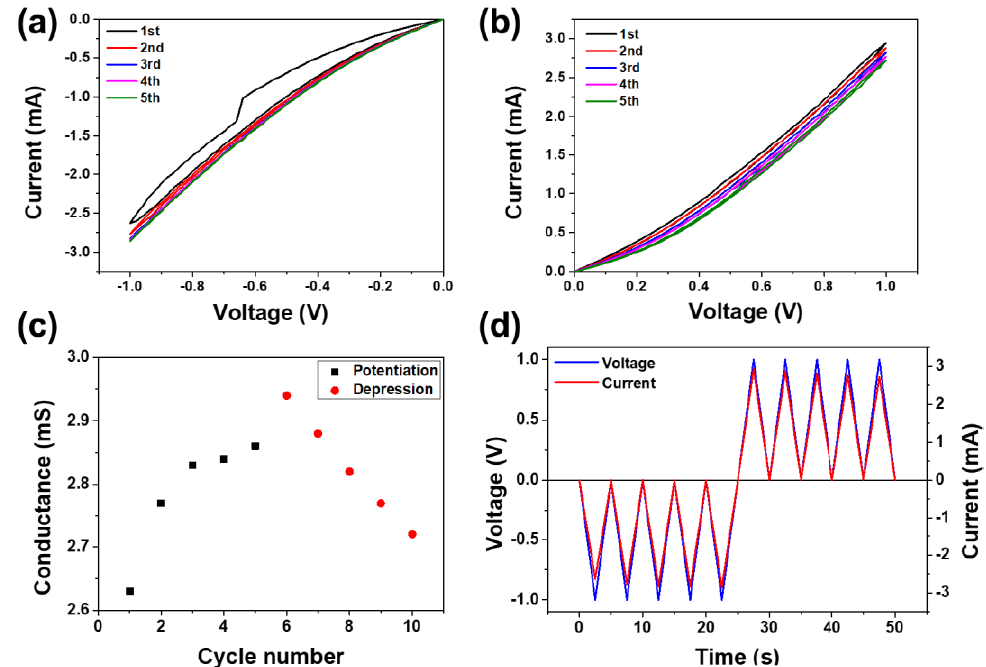
Figure 4. I – V plots of the PCMO film measured by five successive applications of ( a ) negative voltage varying from 0 to − 1.0 V and ( b ) positive voltage varying from 0 to 1.0 V. ( c ) Variations in the conductance of the PCMO memristor with respect to the number of sweeps and ( d ) the current and voltage with respect to time.